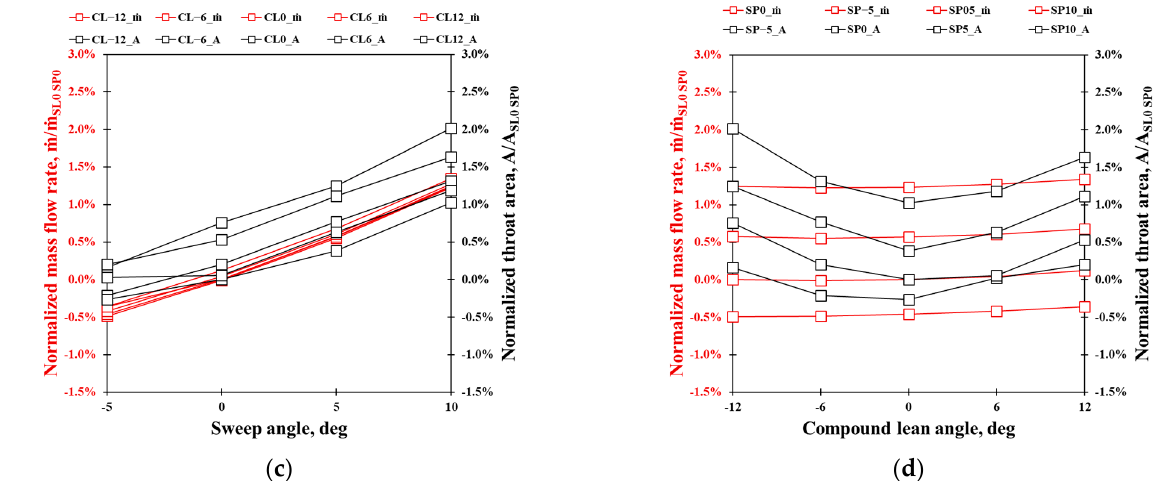
Figure 9. Variation of throat area and mass flow rate of the 3D NGVs: ( a ) Sweep with straight lean angle; ( b ) Straight lean with sweep angle; ( c ) Sweep with compound angle; ( d ) Compound lean with sweep angle.